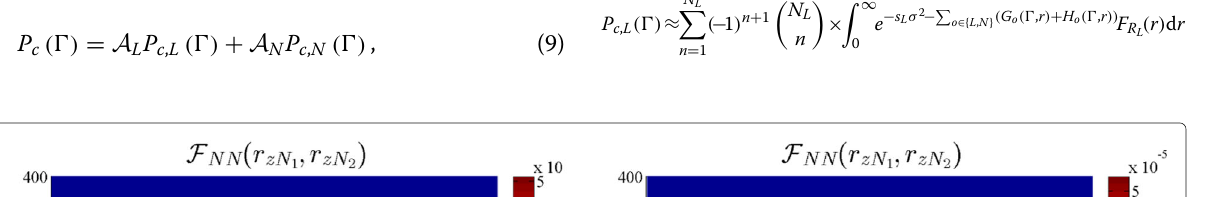
where for b ∈ { L , N } , P c , b ((cid:12)) is the conditional cover- age probability given the reference BS serves a user in (cid:3) b . Moreover, P c , b ((cid:12)) can be obtained as